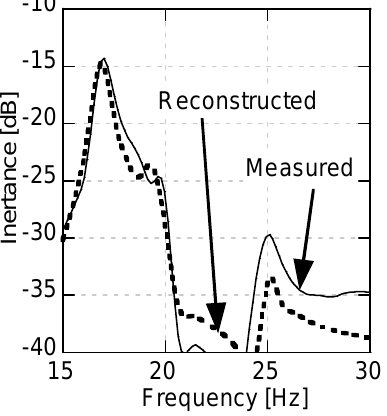
Fig. 17. Vehicle B, RE-FF, FRF of point B.